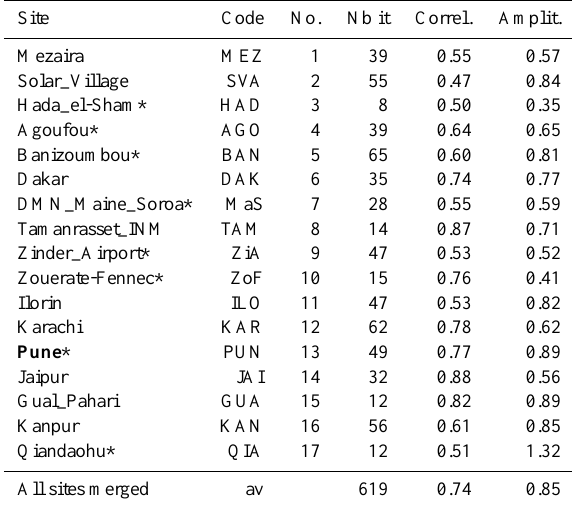
Table 3. Same as for Table 2 except over land. Site Code No.